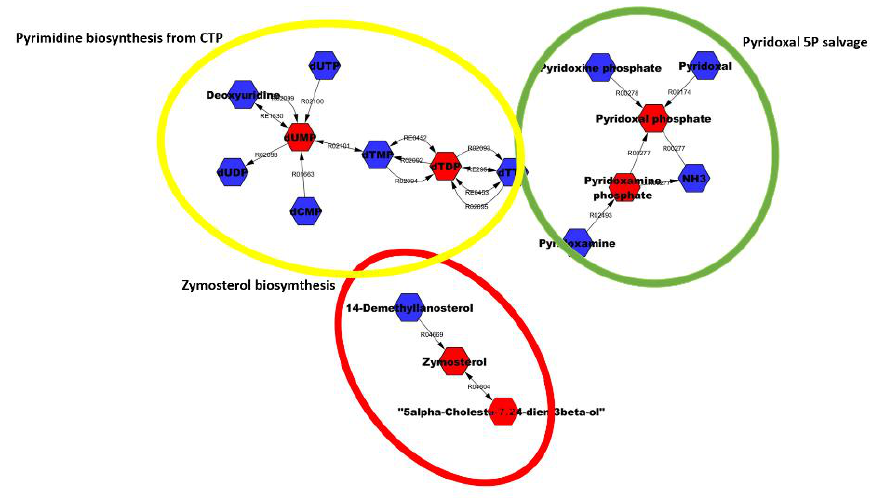
Figure 4. The most significantly modulated terms suggested by metabolomic analysis between the two groups. Table 3. Pathways identified by highly modulated metabolites between PRE run and POST run sera.